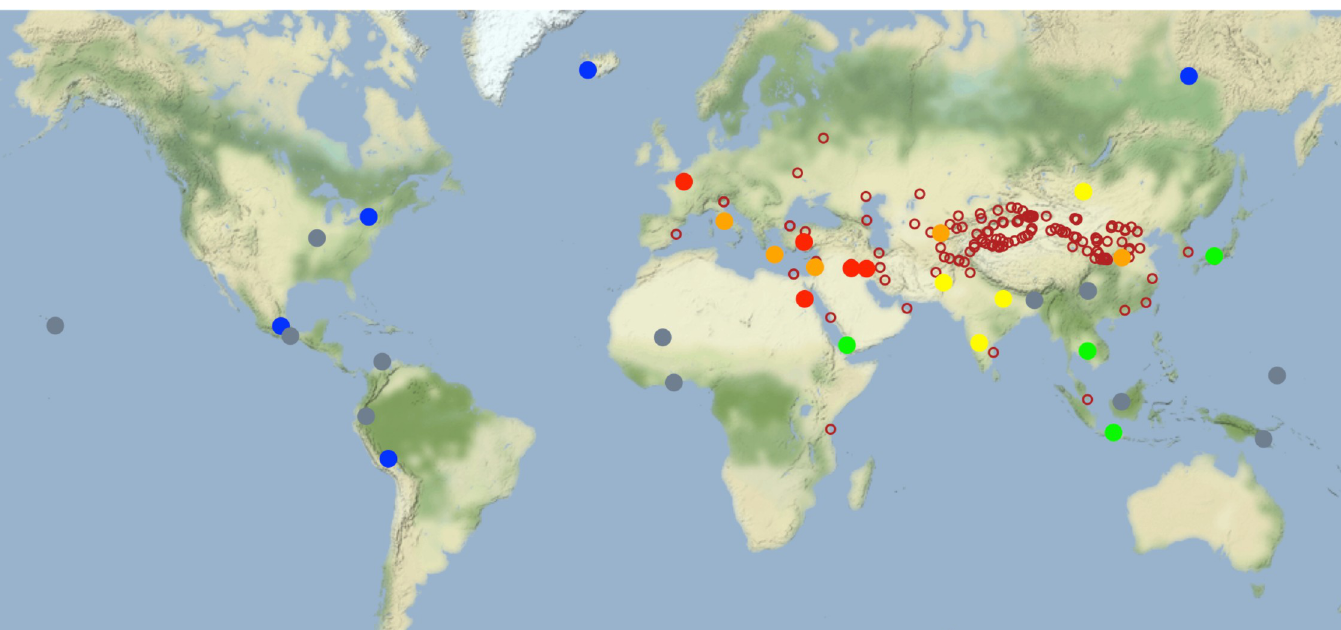
Fig 6. Results of similarity analysis. NGAs are binned into 6 categories according to the earliest time they share 10 or more MilTech variables with another NGA, displayed by color: dark red = 2500 BCE or before; orange = between 2500 and 1500 BCE; yellow = between 1500 and 500 BCE; green = between 500 BCE and 500 CE; blue = after 500 CE; grey = did not display any similarities during our sample period. Unfilled red circles indicate Silk Route Nodes as in Fig 3.